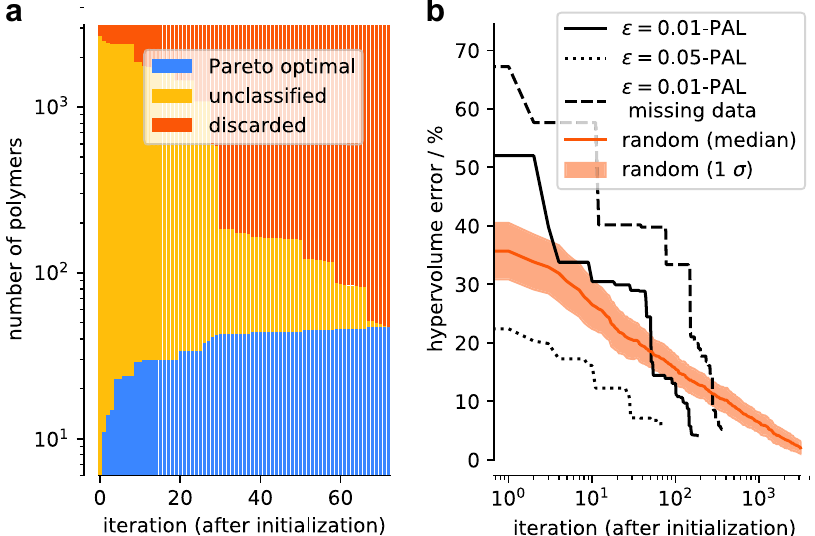
Fig. 6 Classi fi ed points and hypervolume error as a function of the number of iterations. a The ϵ -PAL algorithm classi fi es polymers after each learning iteration with ϵ i = 0.05 for every target and a coregionalized Gaussian process surrogate model. The Gaussian process model was initialized with 60 samples that were selected using a greedy farthest point algorithm within feature space. It is noteworthy that the y -axis is on a log scale. b Hypervolume errors are determined as a function of iteration using the ϵ -PAL algorithm with ϵ i = 0.01 and 0.1 for every target. A larger ϵ i makes the algorithm much more ef fi cient but slightly degrades the fi nal performance. For ϵ i = 0.01, we intentionally leave out a third of the simulation results for Δ G rep from the entire dataset. The method for obtaining improved predictions for missing measurements with coregionalized Gaussian process models is discussed in more detail in Supplementary Note 7. Hypervolume error for random search with mean and SD error bands (bootstrapped with 100 random runs) is shown for comparison. For the ϵ -PAL algorithm, we only consider the points that have been classi fi ed as ϵ -accurate Pareto optimal in the calculation of the hypervolume (i.e., with small ϵ , the number of points in this set will be small in the fi rst iterations, which can lead to larger hypervolume errors). All search procedures were initialized using the same set of initial points, but vary substantially after only one iteration step due to the different hyperparameter values for ϵ . It is noteworthy that the x -axis is on a log scale. Overall, the missing data increase the number of iterations that are needed to classify all materials in the design